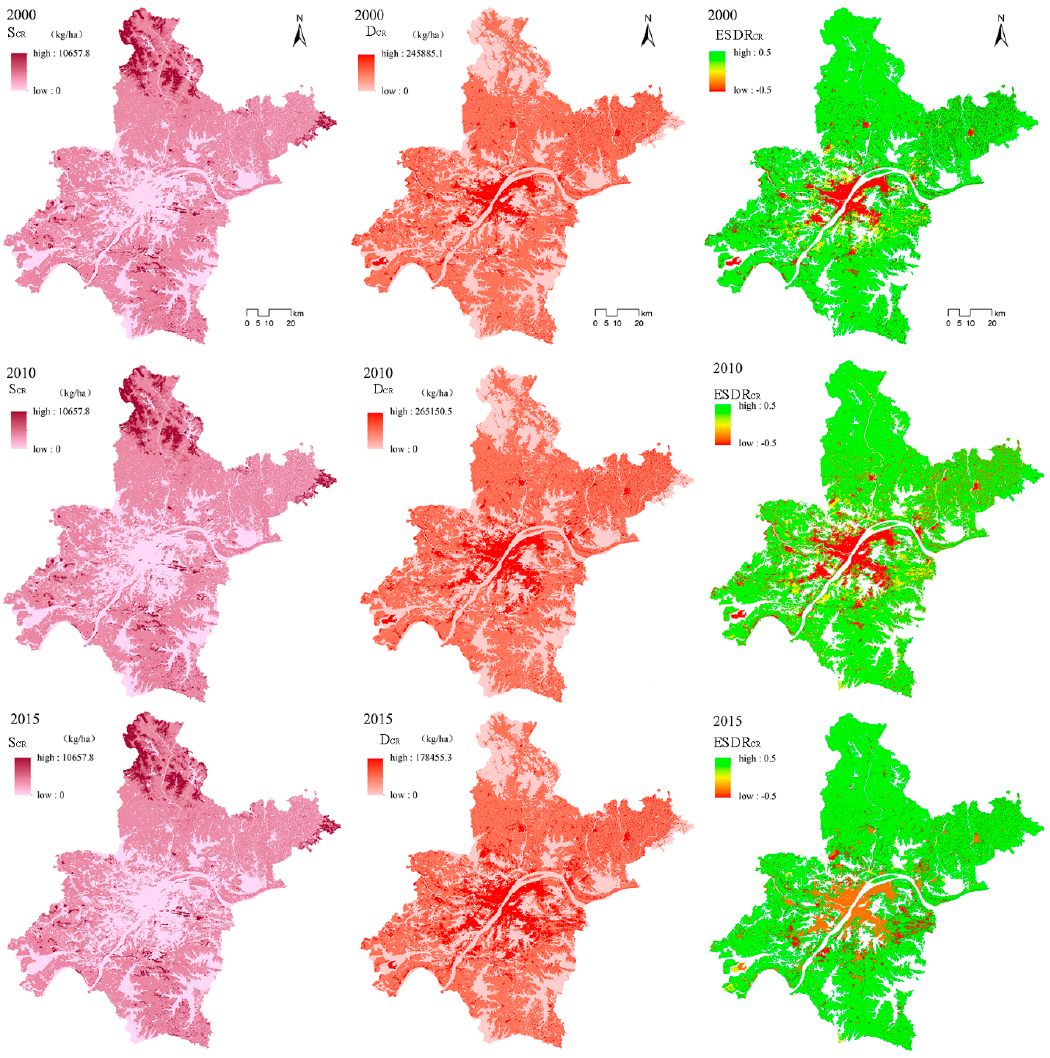
Figure 4. Spatial distribution of supply, demand, and supply–demand ratio of climate regulation service in Wuhan in 2000, 2010, and 2015